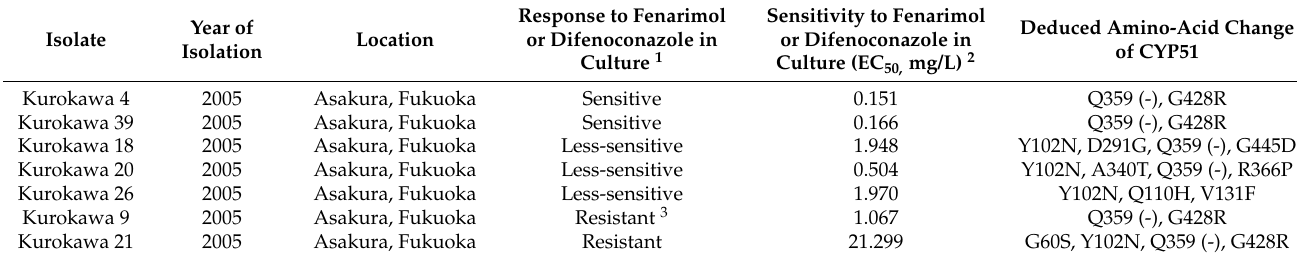
Table 2. Collection information, DMI sensitivity, and deduced amino-acid change of CYP51 for the representative single- spore isolates of Venturia nashicola used in this study.